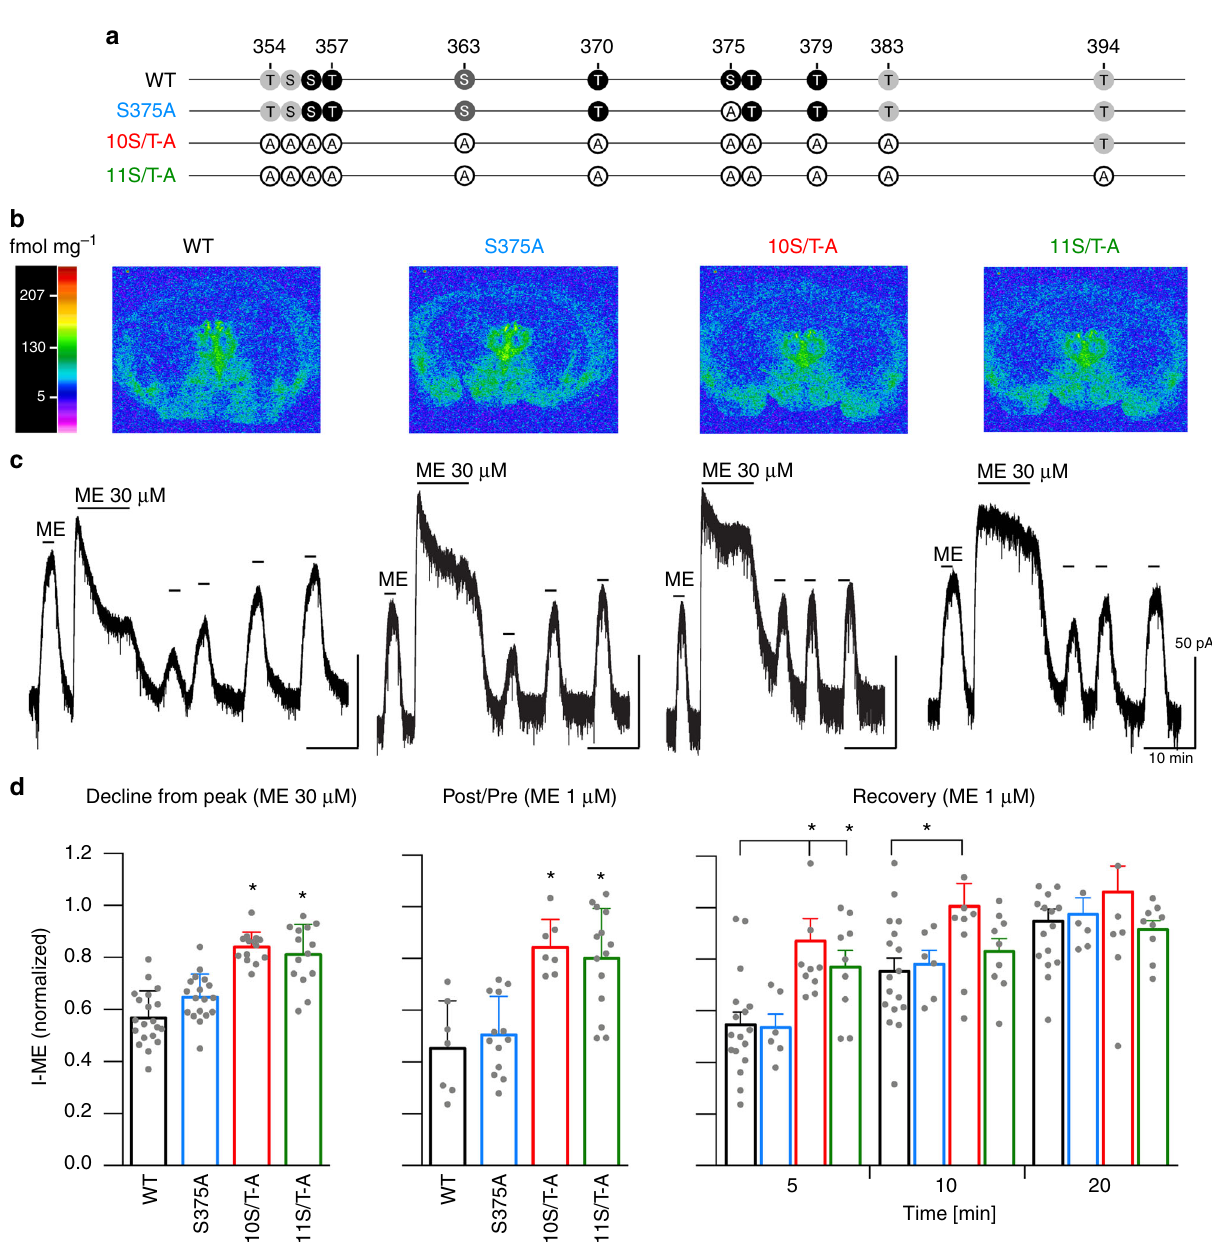
Fig. 1 Inhibition of desensitization in phosphorylation-de fi cient MOP knock-in mice. a Schematic representation of the carboxy-terminal tail of phosphorylation-de fi cient MOP constructs compared to WT MOP, showing potential phosphorylation sites (black: con fi rmed agonist-dependent site; dark grey: con fi rmed constitutive site; light grey: possible site). b [ 3 H]DAMGO binding to MOP as quanti fi ed in autoradiograms of coronal brain sections from WT, S375A, 10S/T-A and 11S/T-A mice at the level of the thalamus (bregma − 1.46) ( n = 4 – 6). The colour bar represents a pseudo-colour interpretation of black and white fi lm images in fmol mg − 1 tissue. c Representative recordings showing acute desensitization and recovery from desensitization in locus coeruleus neurons in WT, S375A, 10S/T-A and 11S/T-A knock-in mice. [Met 5 ]enkephalin (ME, 1 µ M) was applied before and 5, 10 and 20 min after desensitization with a saturating concentration of ME (30 µ M, 10 min). d Left panel: decline from peak current induced by 30 µ M ME over 10 min; middle: decrease in current induced by 1 µ M ME was calculated as the ratio of the current after and before desensitization (I-post/I-pre); right: recovery from desensitization measured 5, 10 and 20 min following desensitization. Data are the means± s.e.m.; * indicates statistically signi fi cant differences compared to WT; one-way ( d , left and middle panel) and two-way ( d , right panel) ANOVA with Dunnett ’ s post hoc dominant phenotype of the mutant receptor (Supplementary temperature, which was set at 56 °C, and cutoff for analgesia Fig. 5). In 10S/T-A and 11S/T-A mice, the maximum possible testing, which was set at 30 s. Under these conditions, the ED 50 value for fentanyl is twofold lower in 10S/T-A and 11S/T-A mice analgesic effect (30-s cutoff) is reached after administration of 0.2 mg/kg fentanyl (Fig. 2a). In contrast, in WT mice, adminis- than in WT mice, indicating that the analgesic potency of fen- tration of 0.3 mg/kg fentanyl is required to achieve the maximum tanyl is increased when carboxyl-terminal phosphorylation and β -arrestin recruitment are abolished (Table 1, Fig. 2a). The possible effect (Fig. 2a). The 50% effective dose (ED 50 ) values determined in the hot-plate test strongly depend on the duration of action of fentanyl is also prolonged (Fig. 2c,